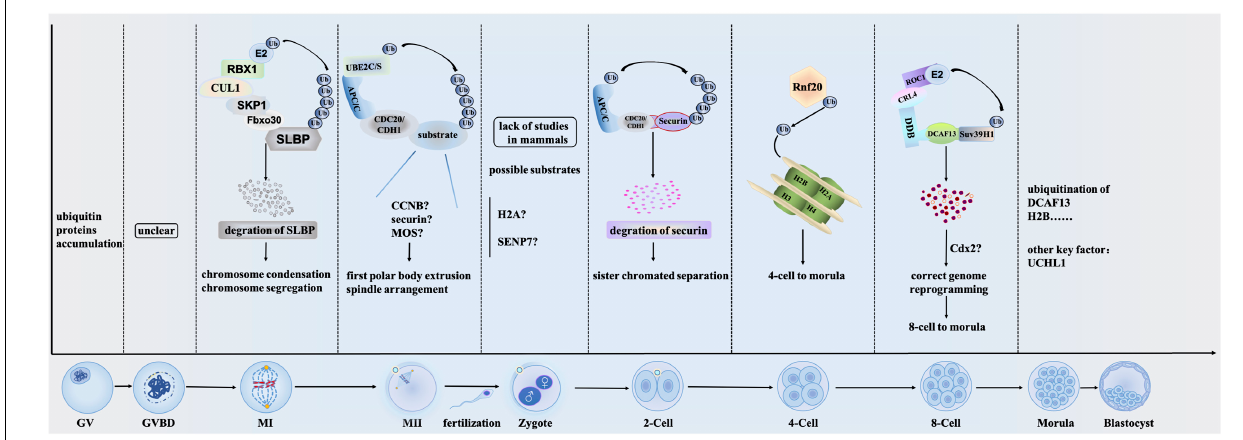
FIGURE 1 | Overview of the main ubiquitination mechanisms during oocyte maturation and preimplantation embryo development. Ubiquitination regulates protein stability during almost all stages of oocyte maturation and embryo development. Initially, ubiquitin proteins accumulate at GV stage (Huo et al., 2004b). While whether and how ubiquitination regulates GVBD stage is unclear by now. In MI stage, SCF Fboxo 30 -mediated SLBP degradation regulates the chromosome condensation and segregation through ubiquitination. After MI stage, ubiquitin-conjugating enzymes UBE2C and UBE2S play roles in the escape from MII arrest (Fujioka et al., 2018). They regulate first polar body extrusion and spindle arrangement via APC/C CDC 20 and APC/C CDH 1 complex. While substrates that are ubiquitinated by UBE2C and UBE2S remain elusive. Zygote stage is the beginning of embryo development, while how ubiquitination plays roles in this stage is lack of studies in mammals. In 2-cell stage, APC/C CDC 20 ubiquitinates securin and regulates sister chromatid separation. During the 4-cell to marula stage, Rnf20 controls the expression of H2B through ubiquitination and is involved in regulating preimplantation embryo development by controlling gene expression. From 8-cell to morula, ubiquitination of Suv39H1 via CRL4 DCAF 13 is important to the genome reprogramming. In morula stage, as a member of the ubiquitin C-terminal hydrolase (UCH) of deubiquitinating enzymes, UCHL1 regulates the morula compaction (Mtango et al., 2012).